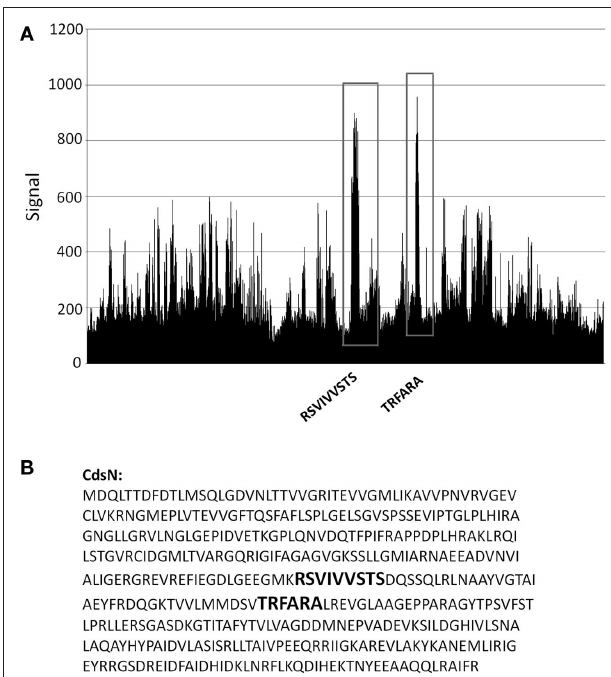
FIgure 2 | Pepscan analysis of the CdsL binding domain on CdsN. An over-lapping peptide library for full length CdsN consisting of 4000 linear and looped peptides was constructed by Pepscan Presto (The Netherlands). His–CdsL was screened against the peptide library to identify CdsN peptides that interact with CdsL. (A) Raw Pepscan data obtained by screening full length His–CdsL against the over-lapping peptide library of 4000 linear and looped CdsN peptides ( x -axis). The two distinct CdsL binding domains are highlighted in black within the vertical boxes, and the signal strength of the interaction is visualized on the y -axis. The two peaks correspond to the sequences RSVIVVSTS and TRFARA. (B) The two amino acid sequences to which CdsL binds (RSVIVVSTS and TRFARA) are bolded within the full length CdsN amino acid sequence.